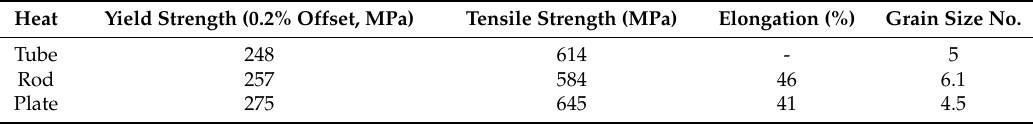
Table 2. Mechanical properties and grain size of Alloy 600 heats used in the study. Heat Yield Strength (0.2% Offset,